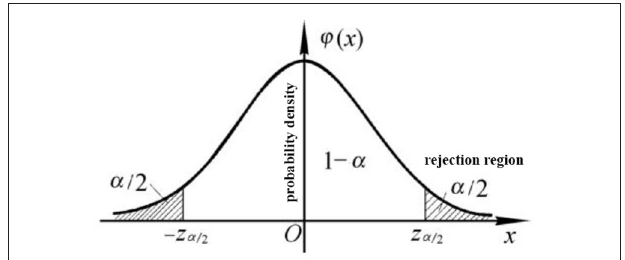
FIGURE 2 | Confidence level and rejection domain in hypothesis testing.